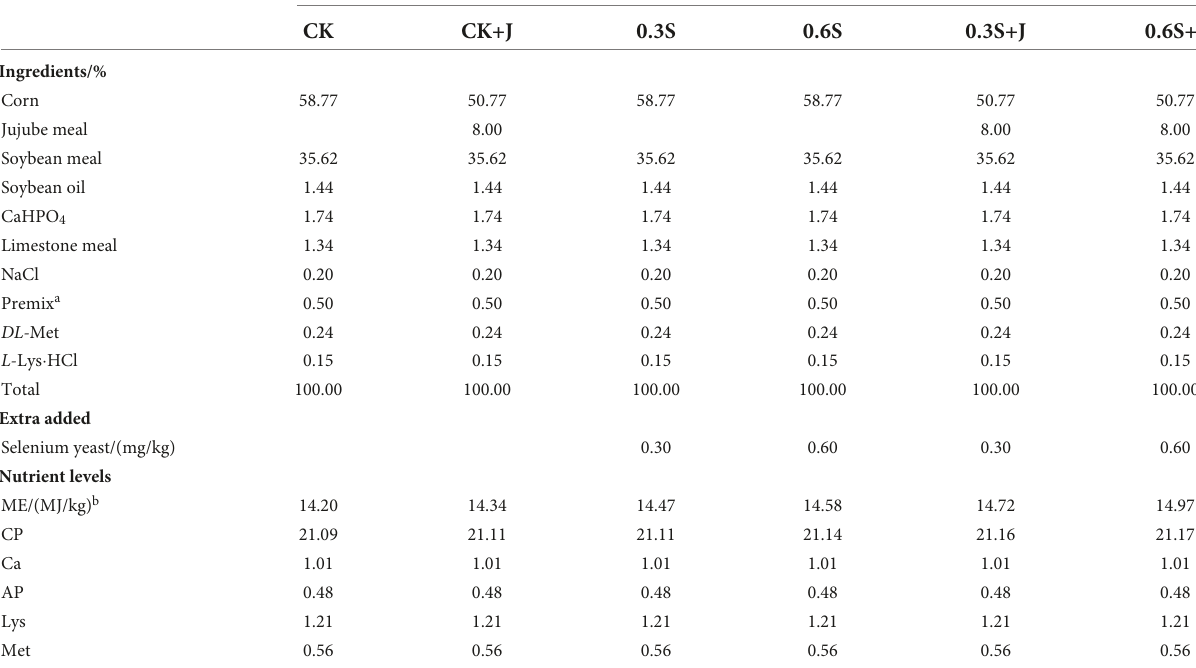
TABLE 1 Composition and nutrient levels of basal diets (as-fed